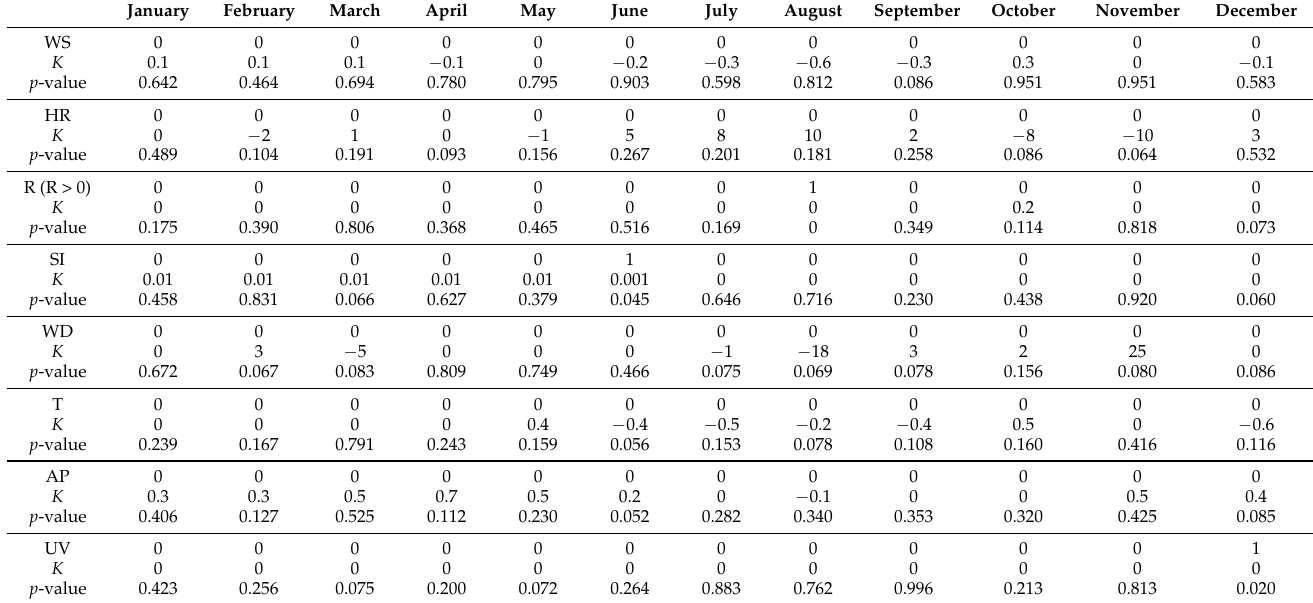
Table 3. Test results, values of the constant K , and p -value for each meteorological